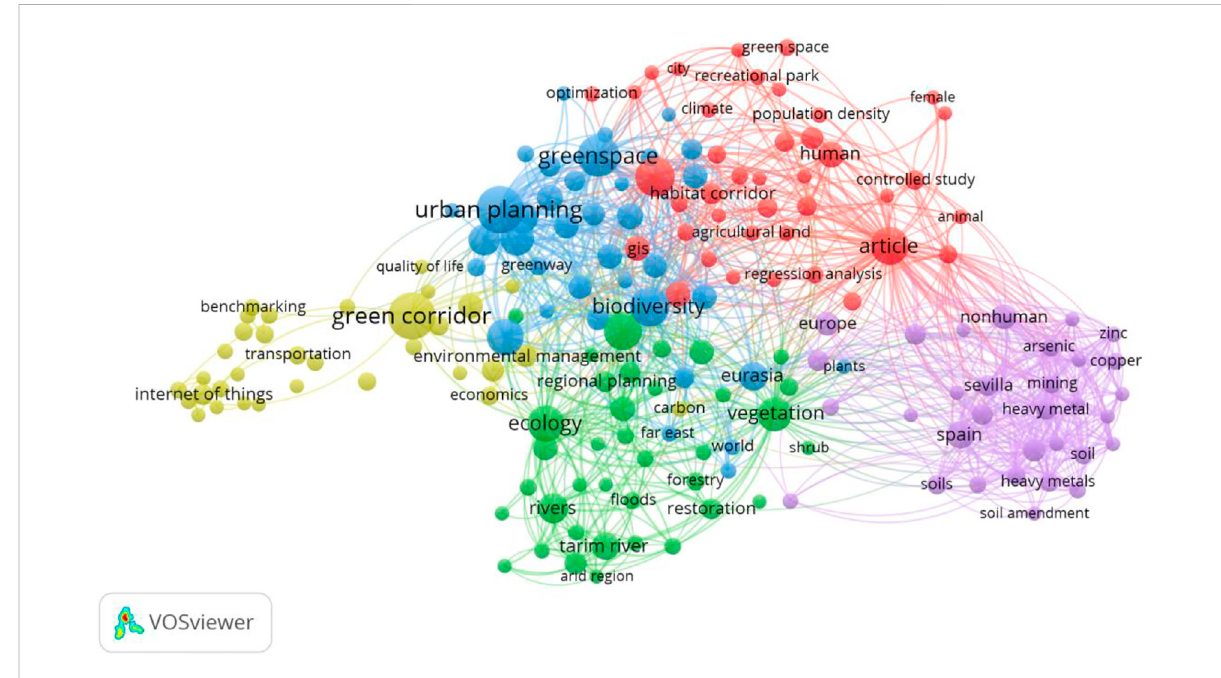
FIGURE 1 Co-word analysis of green corridor